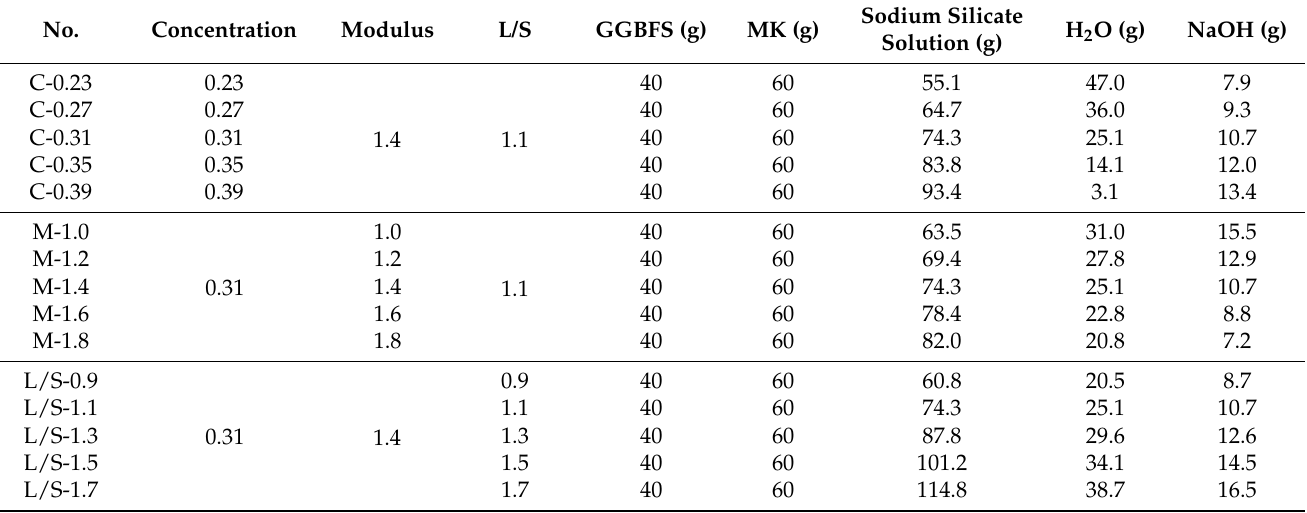
Table 2. Synthesis formulations of MK/GGBFS-blended geopolymer